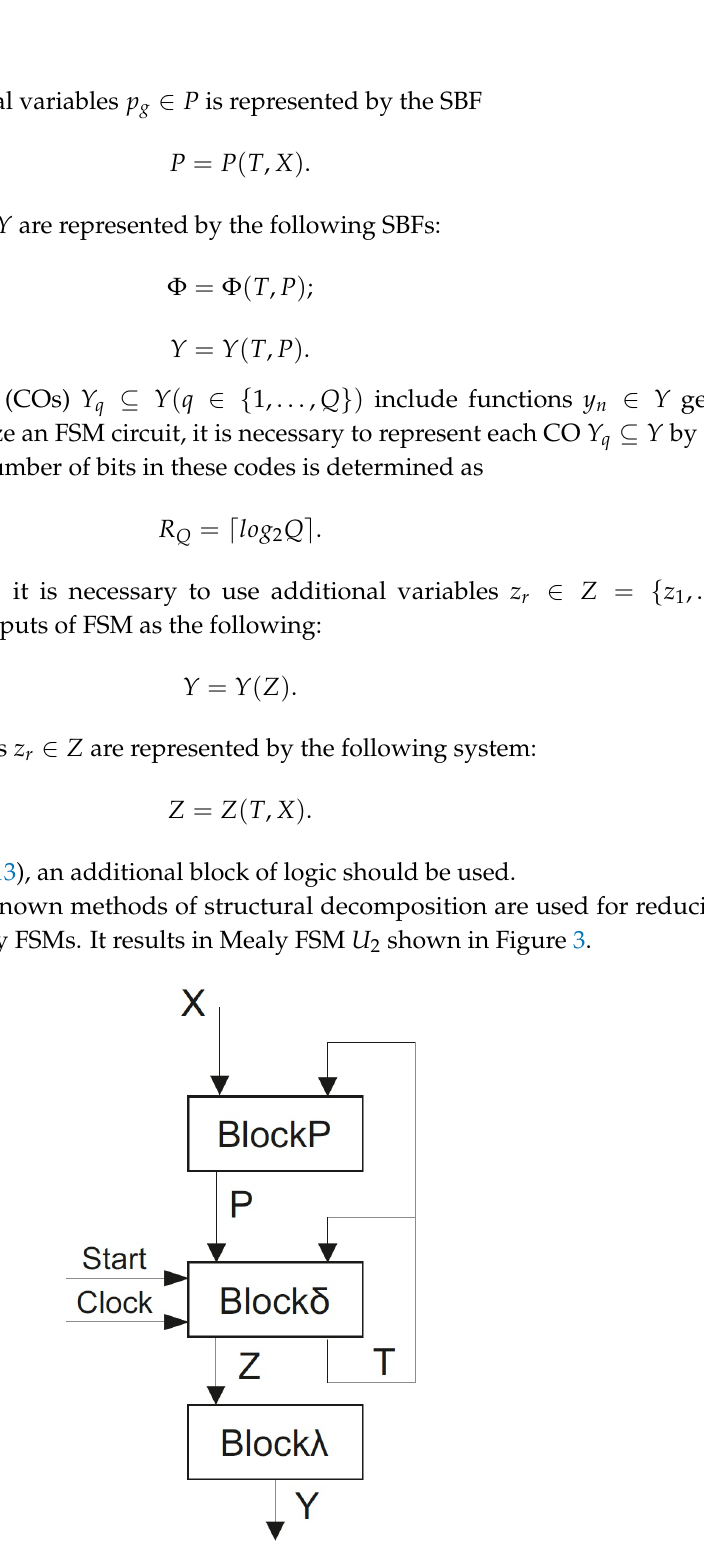
Figure 3. Architecture of Mealy FSM U 2